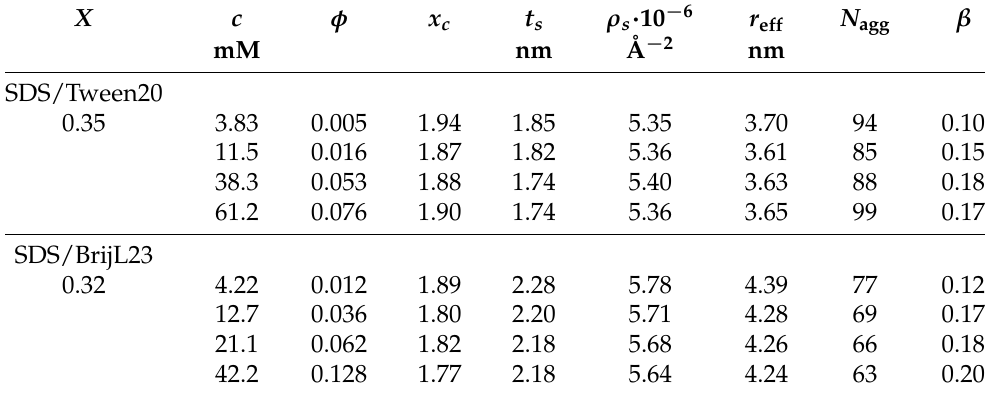
Table 3. Parameters extracted from SANS model fits (core-shell ellipsoid form factor + RMSA structure factor) of mixed nonionic–anionic micelles in D 2 O at